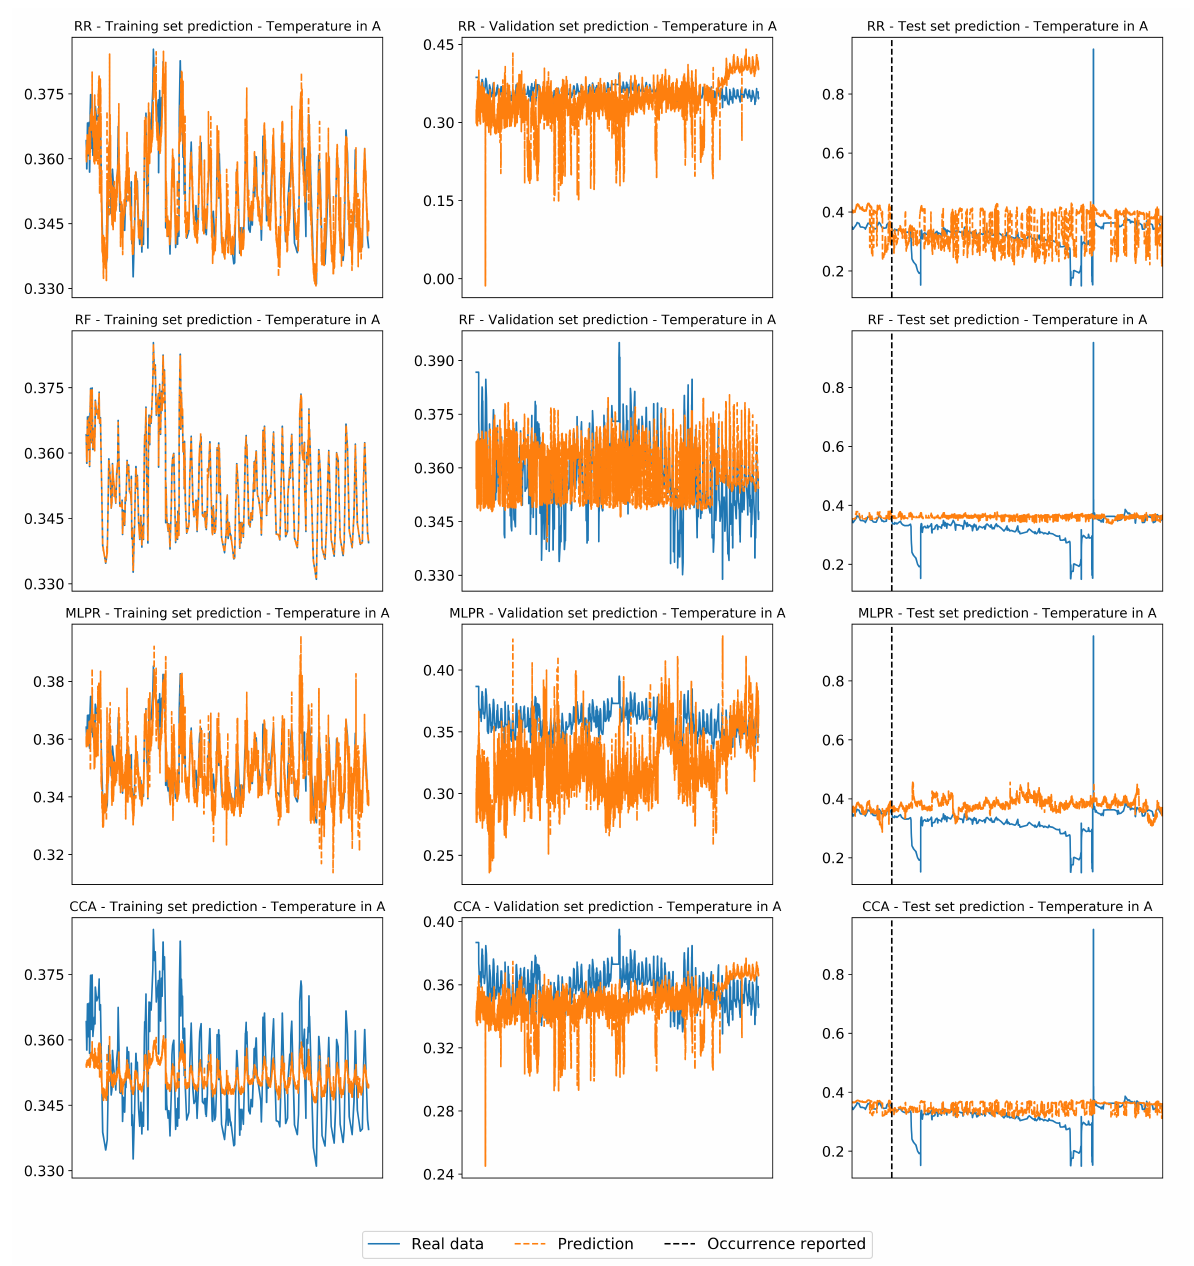
Figure A7. Regressors prediction for dimensionless temperature in fiscal meter 02A (Section A) along Fault-FII without considering variable selection